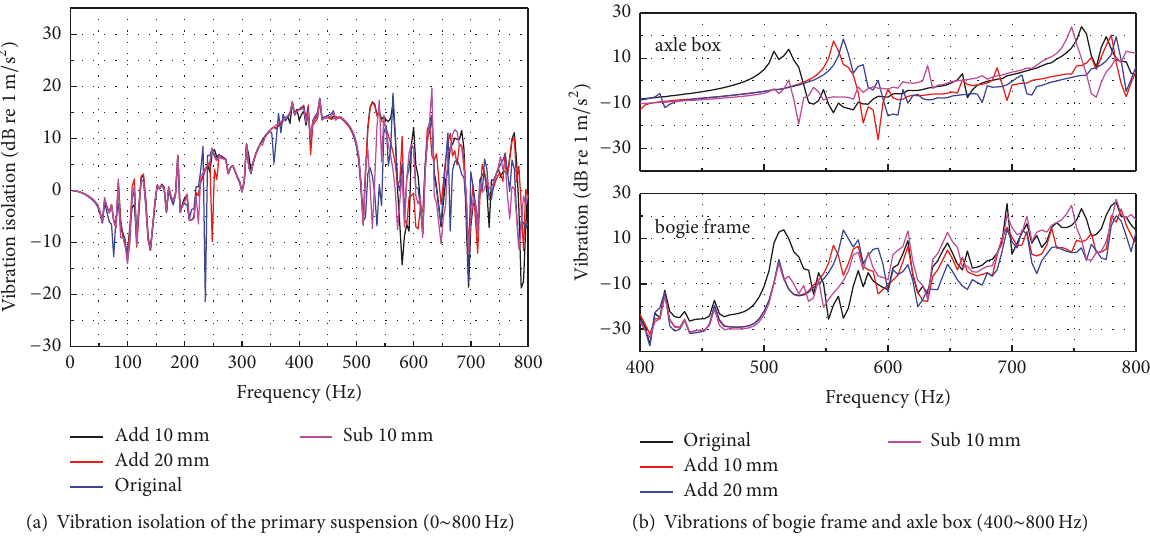
Figure 16: Different radiuses of the wheelset